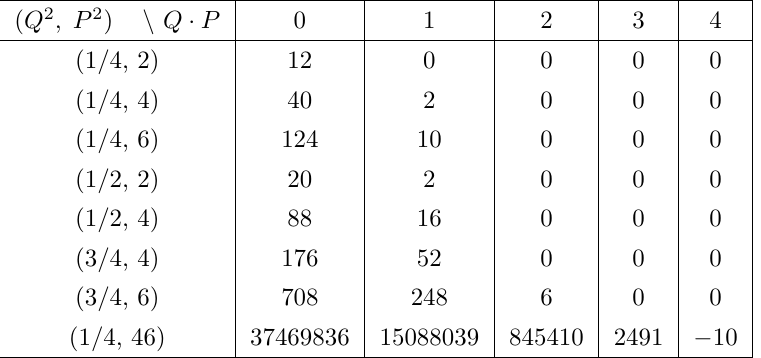
Table 11 . Index of horizon states for the 8 A orbifold of K 3